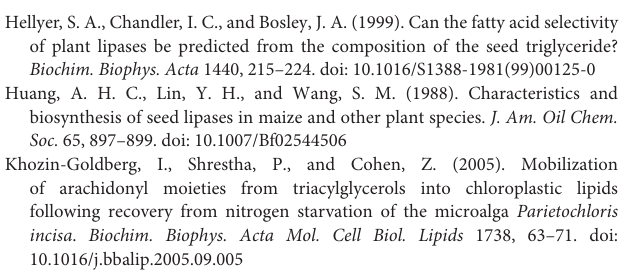
Figure S1 | Seedling development in Columbia and the transgenic Arabidopsis lines after imbibition. DAI, day after imbibition; Col, Columbia; SDA, ARA, DHA are the transgenic lines expressing relevant pathways; Null-DHA is the null segregant from DHA-line. Figure S2 | Biosynthesis of PUFA-containing MGDG and DGDG species during seedling development in Columbia, SDA-, ARA-, and DHA-Arabidopsis lines. The two numbers of the species denotes total number of carbons and total number of double bonds of two fatty acids in the species. (A) MGDG; (B)